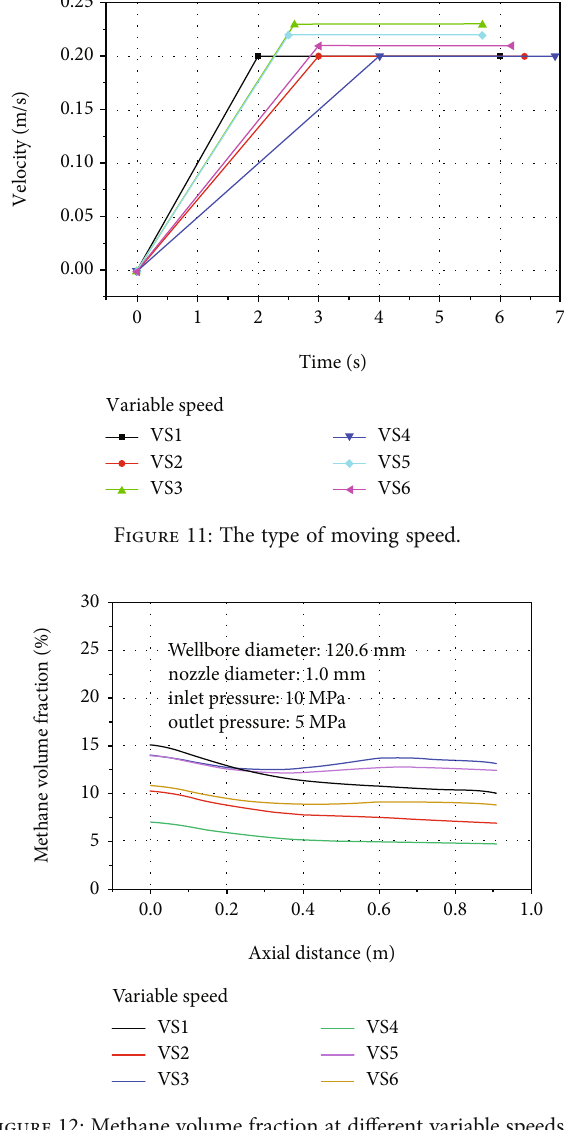
Figure 12: Methane volume fraction at di ff erent variable speeds in